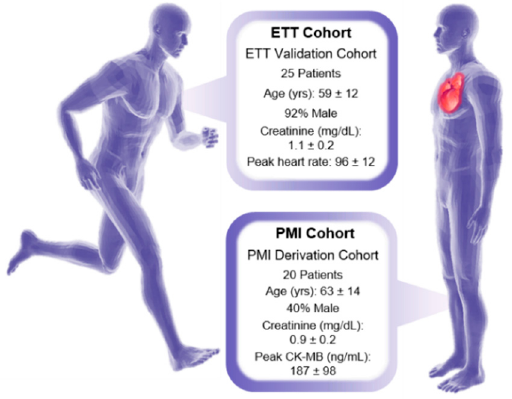
Figure 1. Demographics for the PMI cohort ( left ) and ETT cohort ( right ). Continuous variables are given as mean ± standard deviation and categorical variables are shown as percentages.